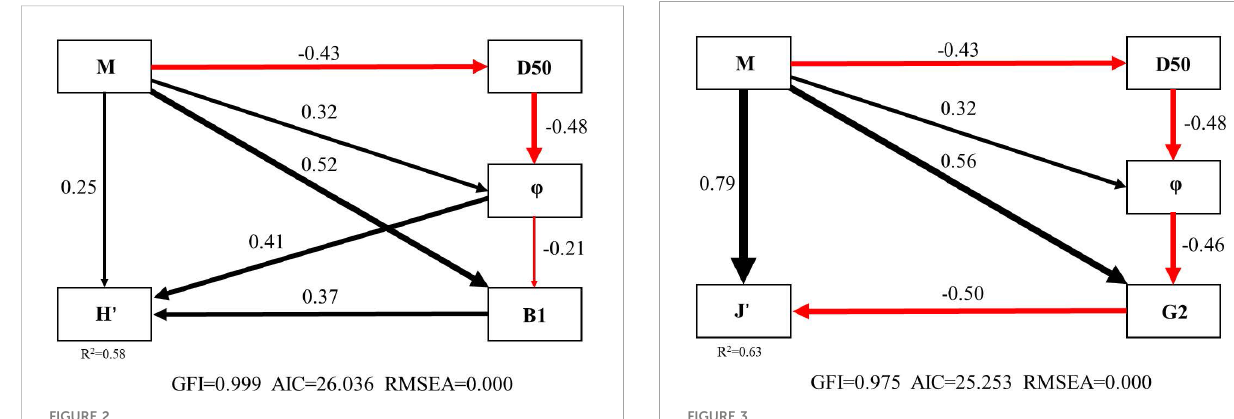
FIGURE 3 The SEM (Structural Equation Model) for Manila clam- J' (M 、 G2 、 j 、 D50 and J' represent the biomass of Manila clam, the biomass of functional group G2, water content, particle size and Pielou ’ s evenness index of macrobenthic community, respectively. The black arrow indicates a positive effect, and the red arrow indicates a negative